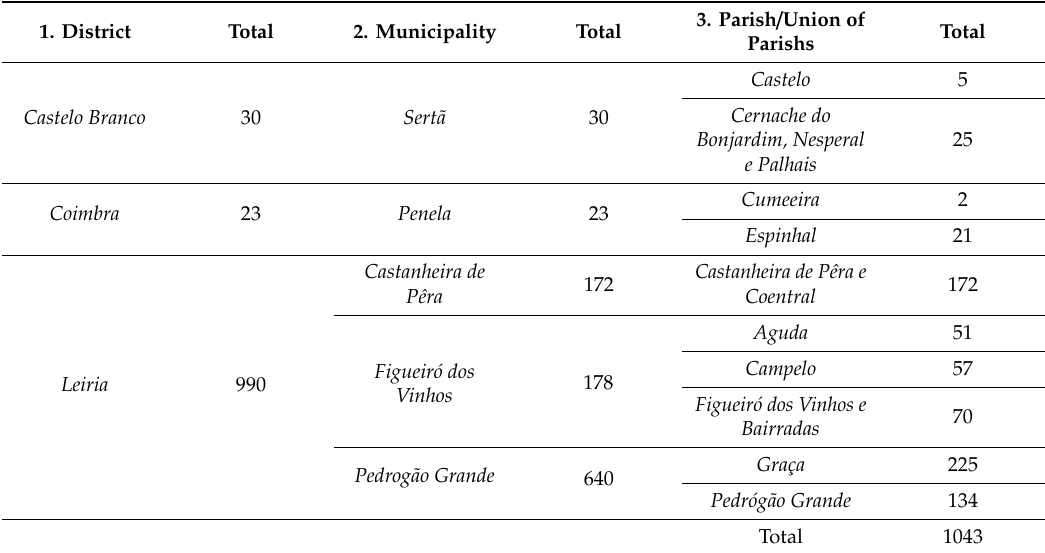
Table 2. Resume of the number and distribution of the damaged structures considered for analysis, among the three Portuguese Administrative